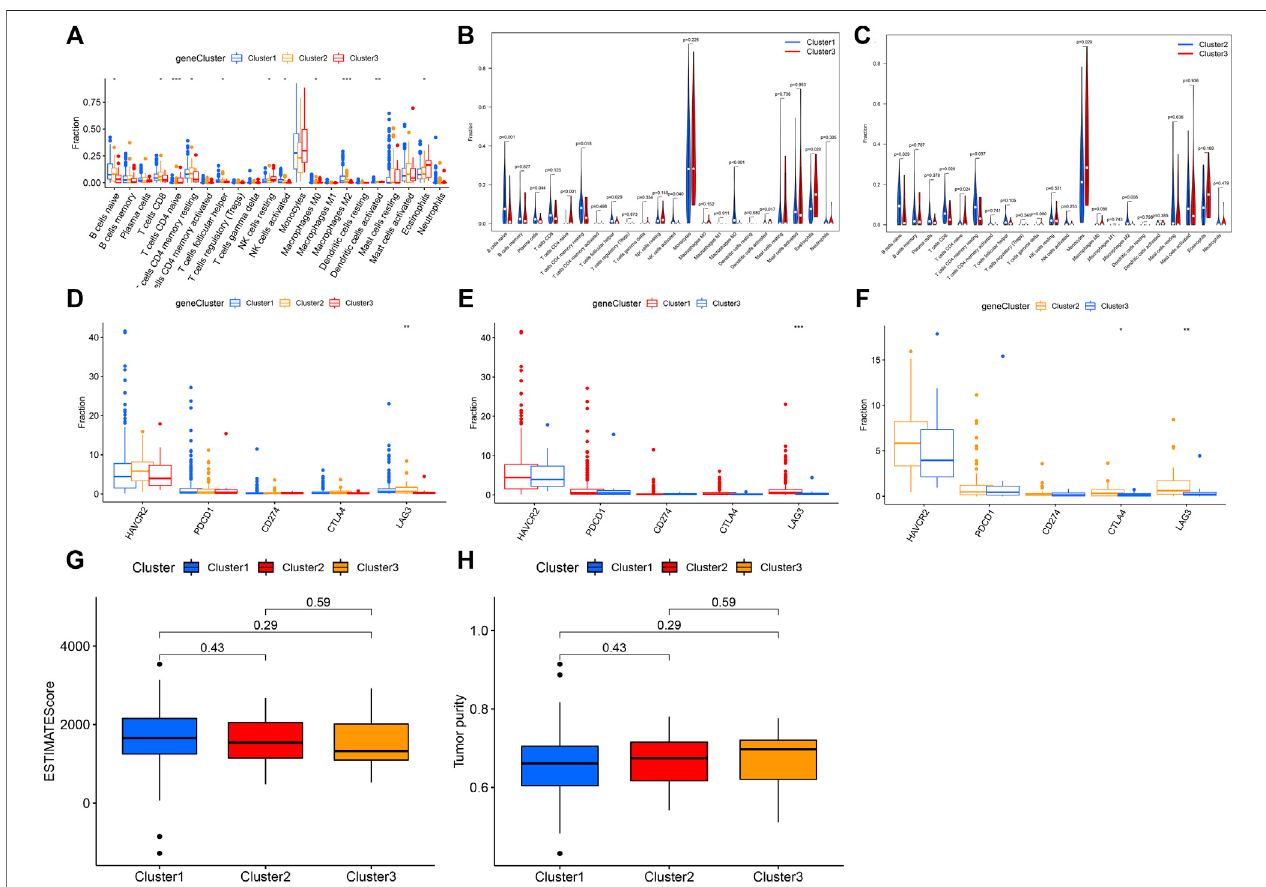
FIGURE 4 | Immunological analysis among different clusters. (A) Content of 22 immune cell types in three clusters. (B) Content of 22 immune cell types between cluster 1 and cluster 3. (C) Content of 22 immune cell types between cluster 2 and cluster 3. (D) Five immune checkpoint expressions in three clusters. (E) Five immune checkpoint expressions between cluster 1 and cluster 3. (F) Five immune checkpoint expressions between cluster 2 and cluster 3. (G) Differences in the estimate score between the three clusters. (H) Differences in tumor purity between the three